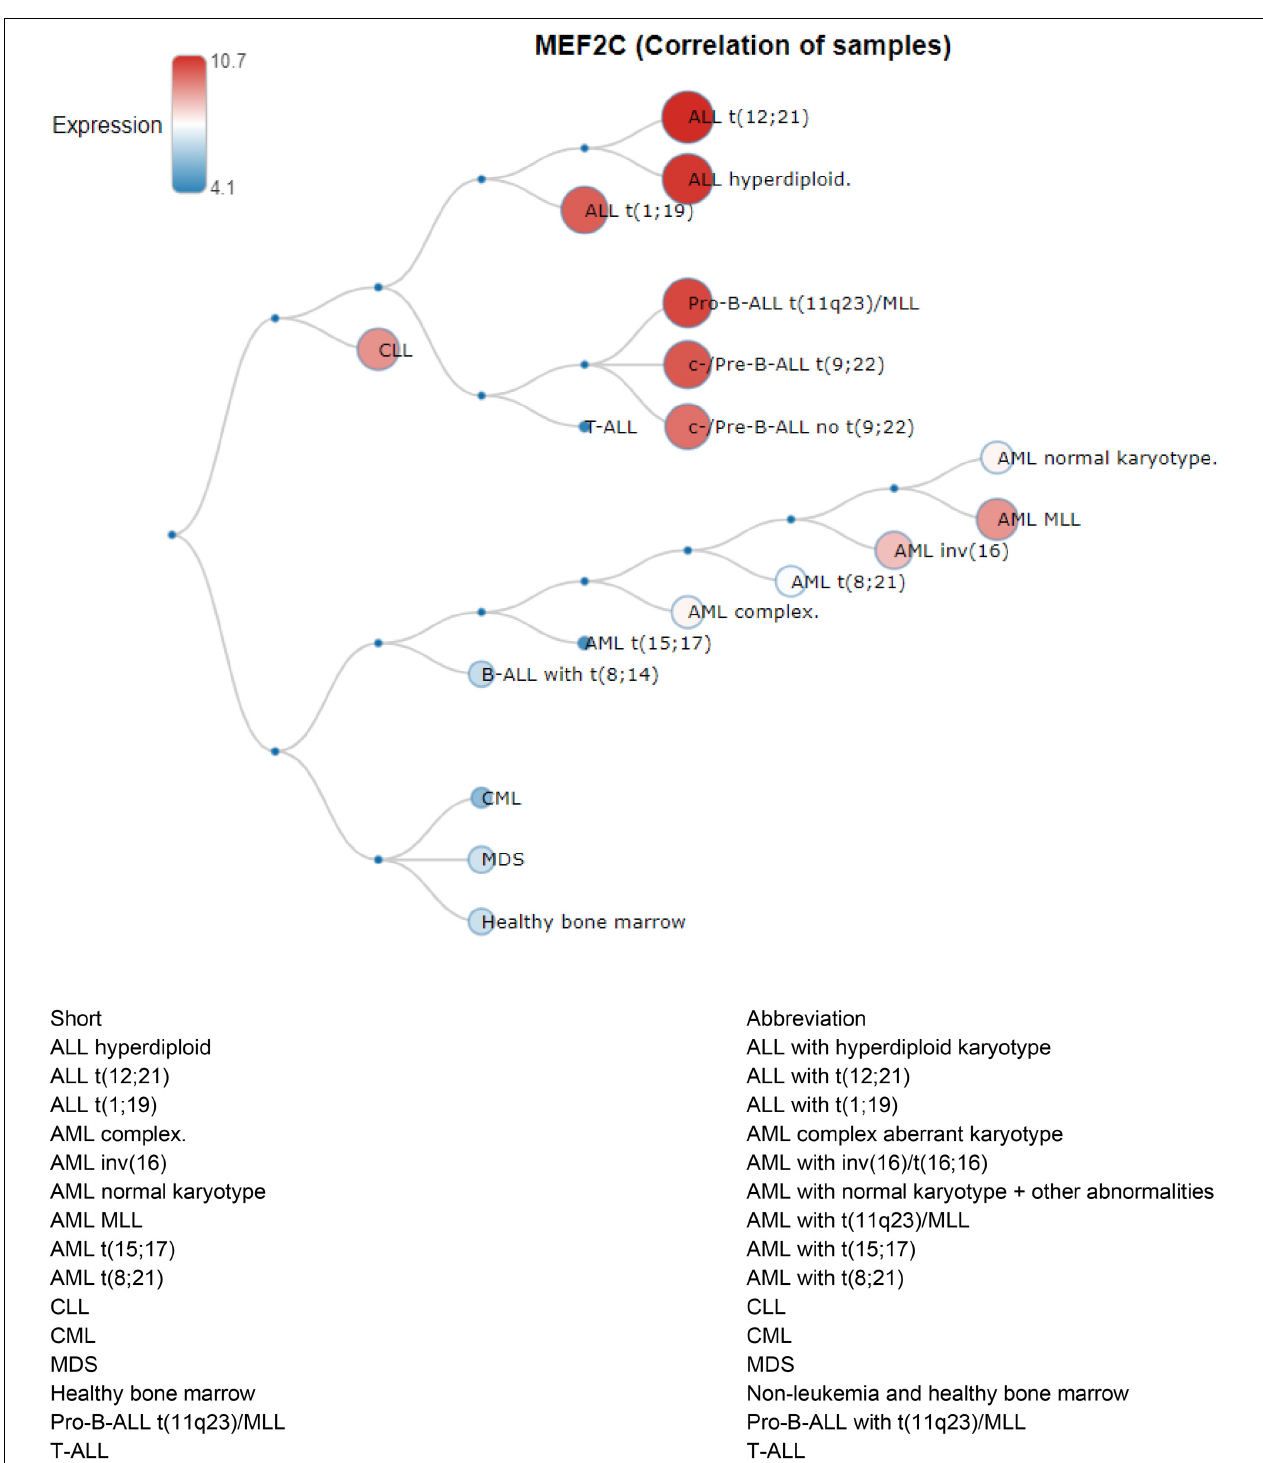
FIGURE 7 | MEF2C (Correlation of samples) in Human AML, ALL and preleukemic stages cells are from GSE13159.